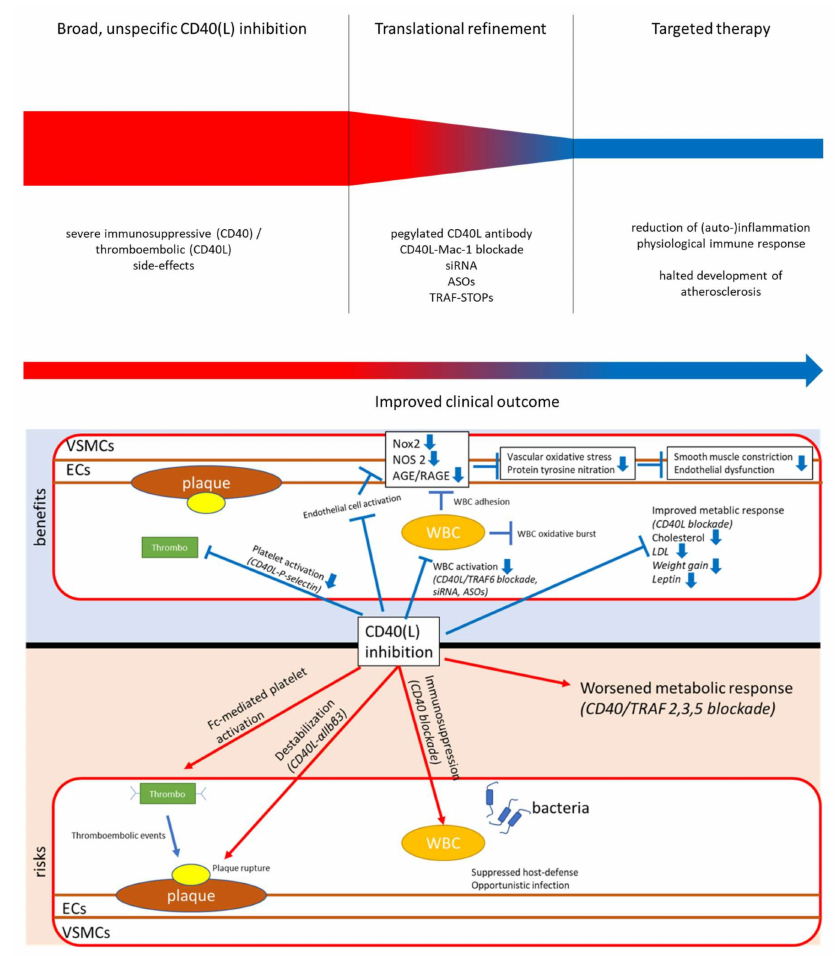
Figure 3. Upper panel: Proposed translational strategy for improved anti-inflammatory therapy using CD40–CD40L-antagonizing approaches. Lower panel: Key mechanisms of inflammation, atherothrombosis, oxidative stress and endothelial dysfunction. Improvement of these adverse key mechanisms by CD40(L) / TRAF inhibition. siRNA, small interfering RNA; ASOs, antisense oligonucleotides; TRAF-STOPs, inhibitors of TNF receptor associated factor; ECs, endothelial cells; VSMCs, vascular smooth muscle cells; NOX2, phagocytic NADPH oxidase (gp91phox); NOS2, inducible nitricoxidesynthase; AGE,advancedglycationendproducts; RAGE,receptorforAGE;LDL,lowdensity lipoprotein; WBC, white blood